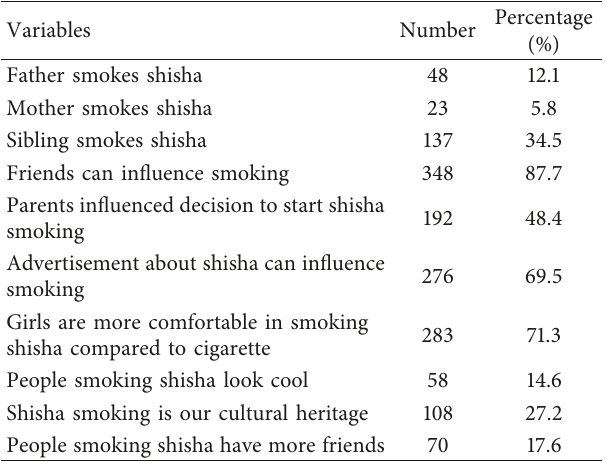
Table 3: Social environment characteristics of the study